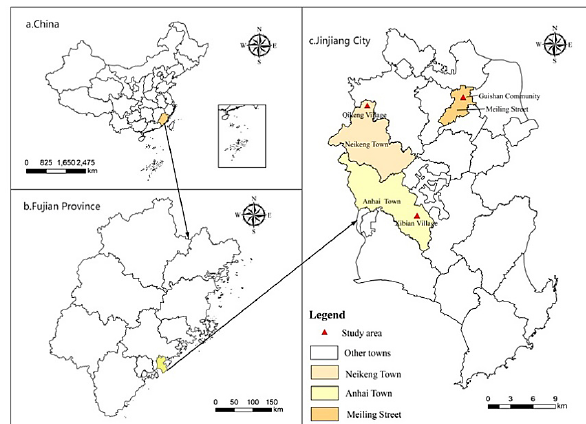
Figure 2. Three empirical areas